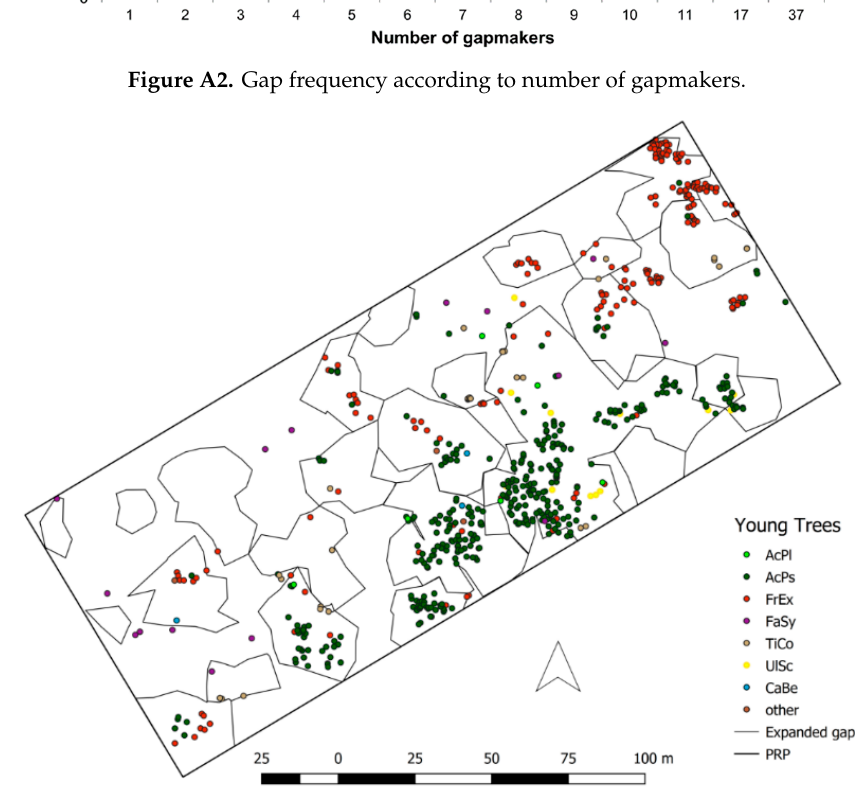
Figure A3. Young trees (dbh 4–8 cm, about to recruit into the middle stand height layer) of A. pseudoplatanus and F. excelsior dominate canopy openings. A. pseudoplatanus is almost absent in the closed canopy, while young trees of F. sylvatica grow mainly under closed canopy.